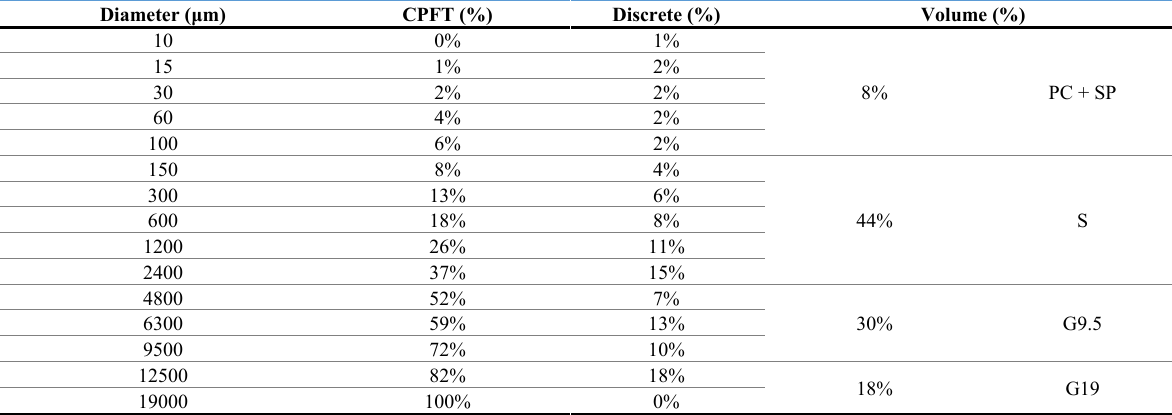
Table 5. Application of the Alfred model with q = 0.45.